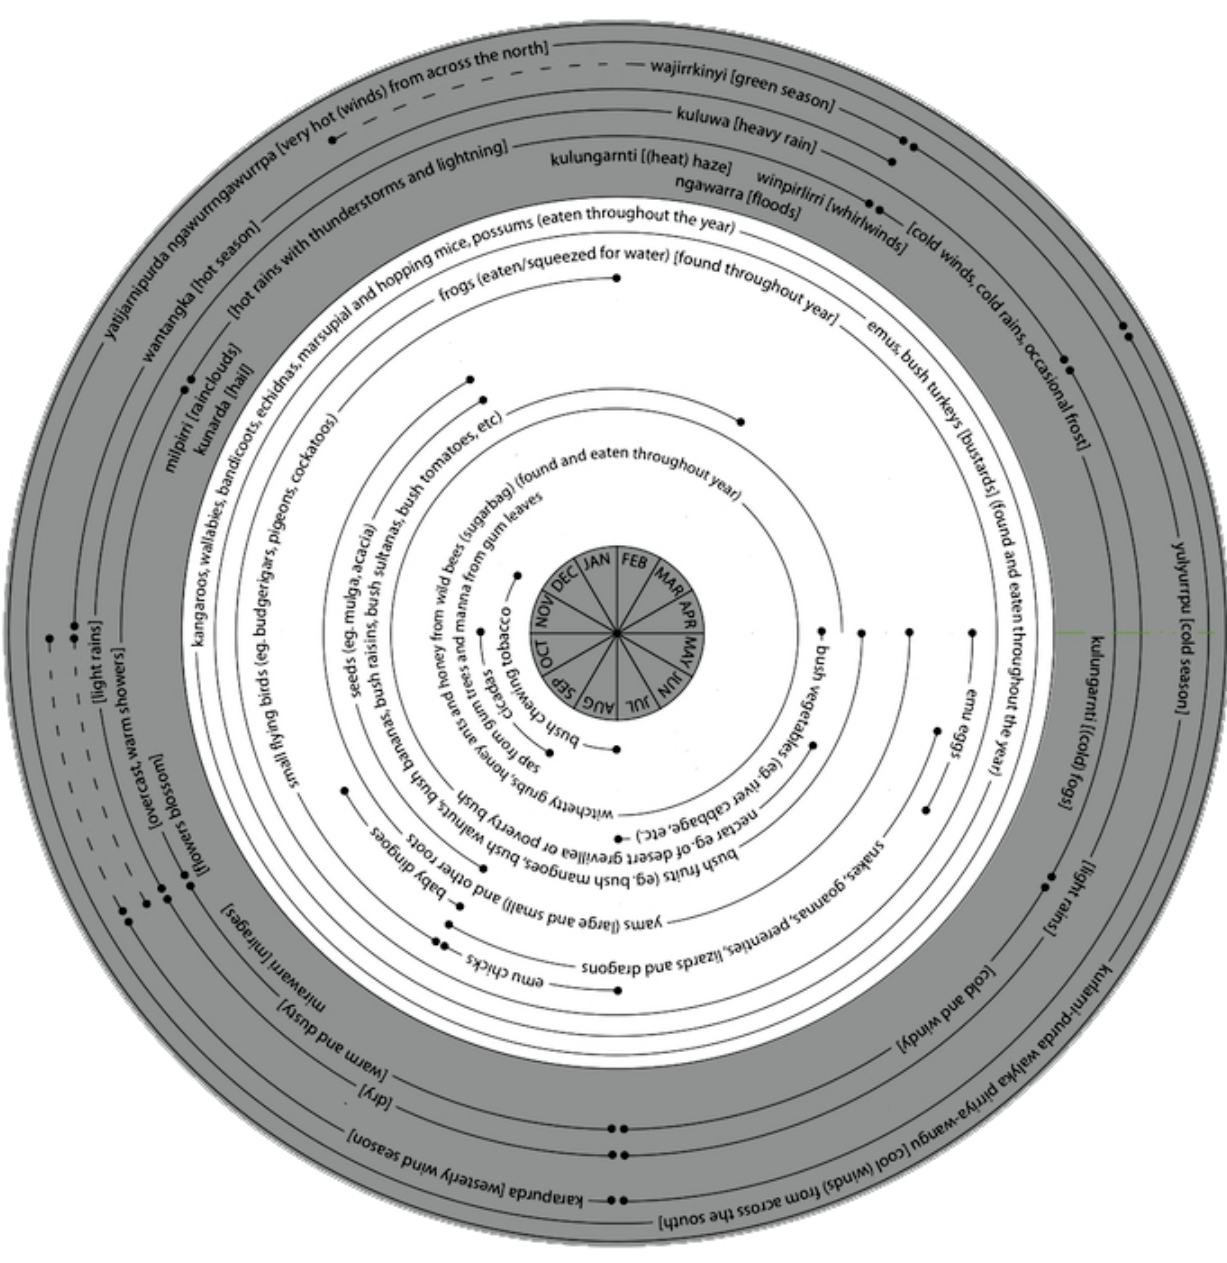
Fig. 1. A Warlpiri calendar from central Australia showing a representation of traditional seasonal knowledge framed by the 12-month Gregorian calendar. Redrawn from Hoogenraad and Robertson (1997) and used with